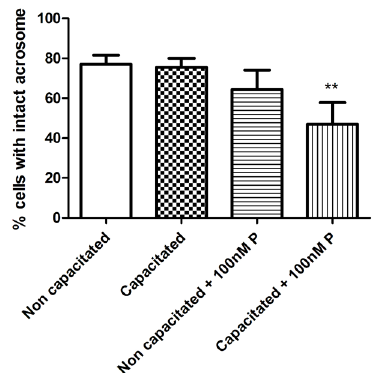
Figure 7. Effects of progesterone (P) on the acrosome reaction in non-capacitated and capacitated boar sperm cells. Cells were either left in non-capacitating or capacitating media for 3 hours followed by incubation with 100nM progesterone. Progesterone significantly increases the percentage of boar sperm cells undergoing spontaneous acrosome reaction. Data are analysed using paired students t-test. ** indicates significantly different from capacitated cells (P<0.05).